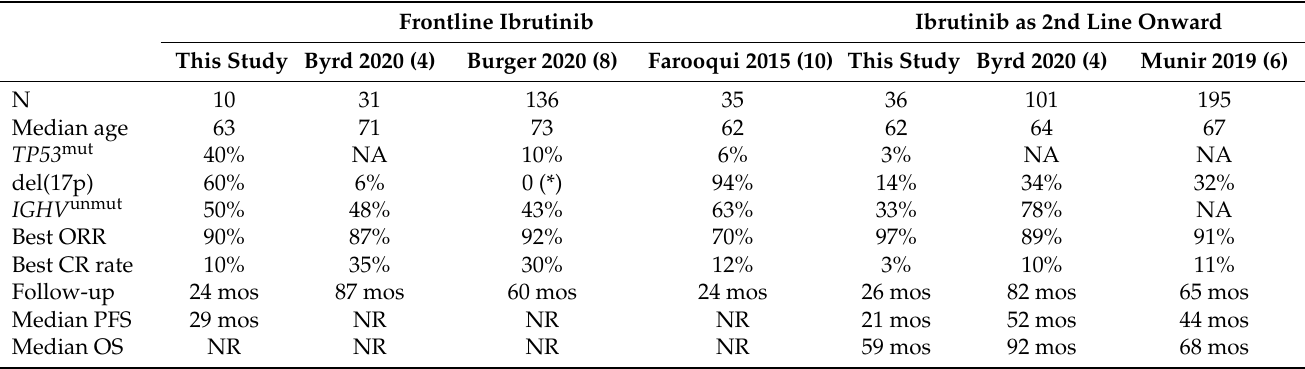
Table 5. Comparisons with phase 1–3 prospective